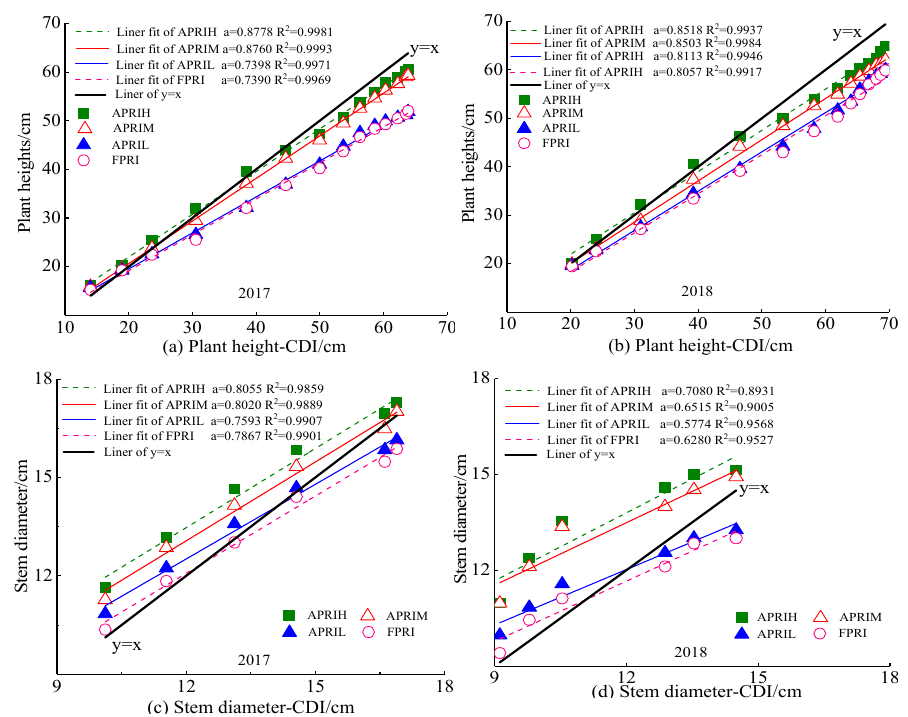
Figure 4. Plant height and stem diameter under different irrigation methods. Note: “a” represents the slope of the fitted line. The fitted straight line indicates the growth rate of plant height ( a , b ) and stem diameter ( c , d ) relative to conventional drip irrigation (CDI) treatment under alternate partial root-zone irrigation (APRI) and fixed partial root-zoon drip irrigation (FPRI) treatment, and the points indicate the actual measured values of plant height and stem diameter for each treatment, line y = x indicates the growth rate of the plant height and stem diameter of the CDI